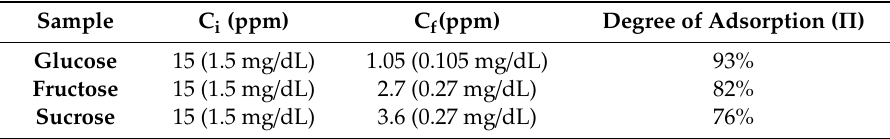
Figure 6. ( a1 , a2 ) The UV-vis spectra of the di ff erent concentration of glucose ( b1 , b2 ) The UV-vis spectra of the di ff erent concentration of fructose, ( c1 , c2 ) The UV-vis spectra of the di ff erent concentrations of sucrose. The calibration curve for ( a3 ) glucose, ( b3 ) fructose, and ( c3 ) sucrose. Table 2. The concentrations of the sugar before and after adsorption with the sensing layer and the degree of adsorption of the sensing